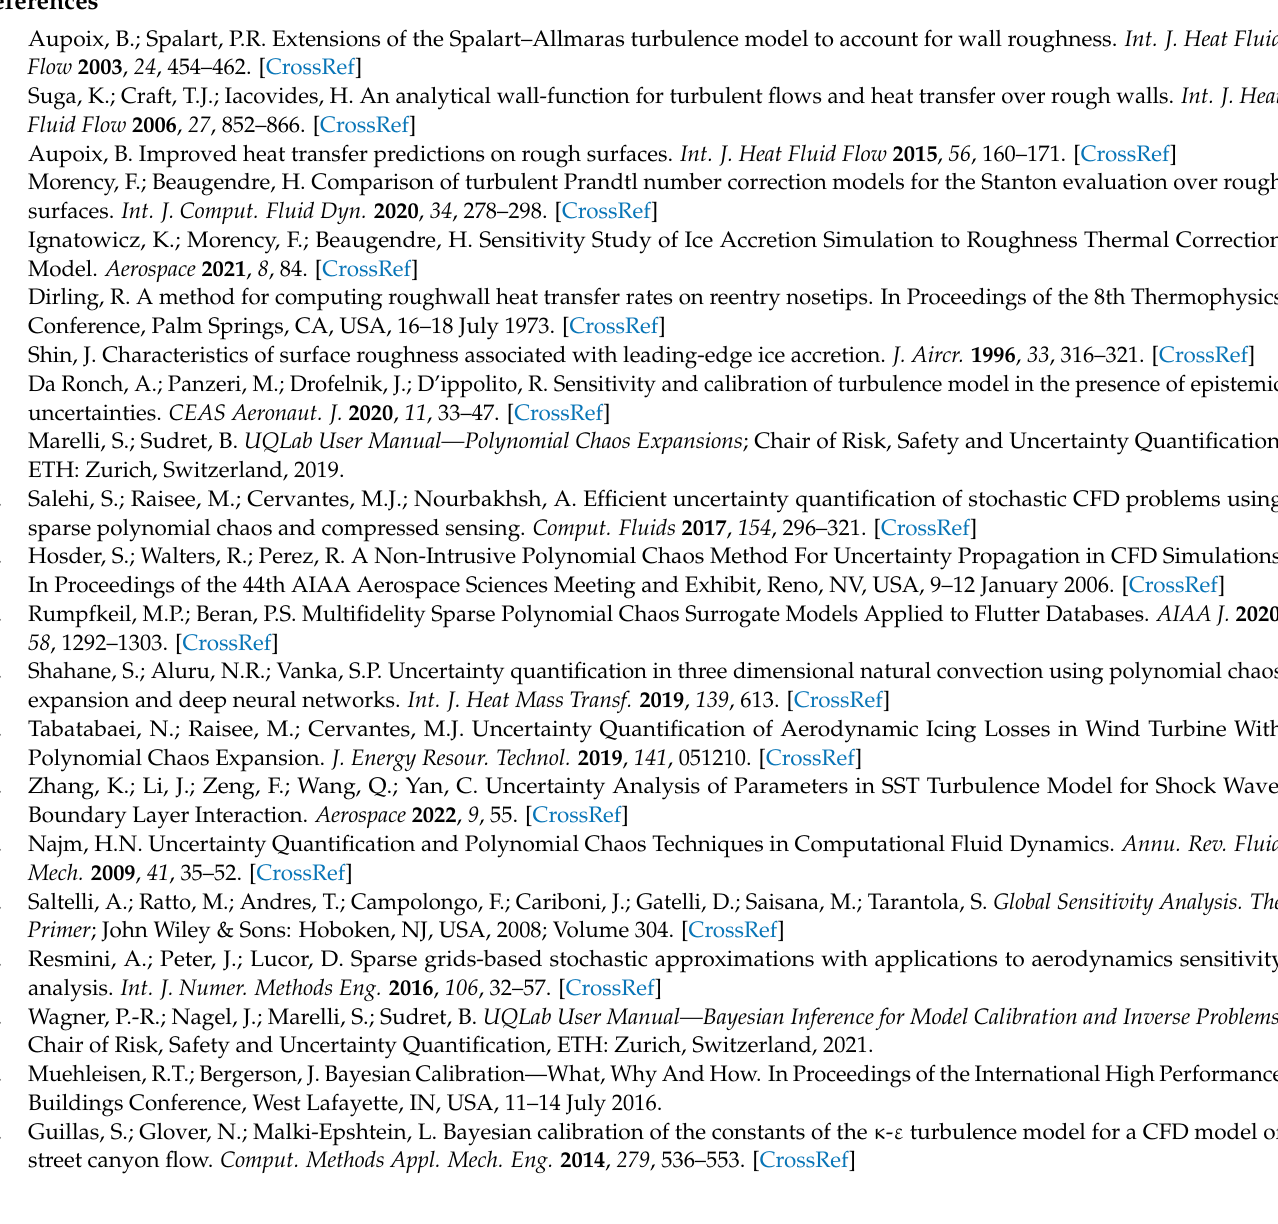
Table A1 shows low GCIs—mainly below 1% except for one which is at 1.4%. For instance, for the monitored h c at 0.8 m on the fine mesh, the interpretation of the GCI value is that the uncertainty on the monitored h c due to the mesh refinement is 0.1%. Applying the same interpretation for each value denotes a satisfactory mesh convergence study. To be conservative and confident about the quality of the CFD results, even with the various roughness patterns planned to be run, the fine mesh is retained for the rest of the